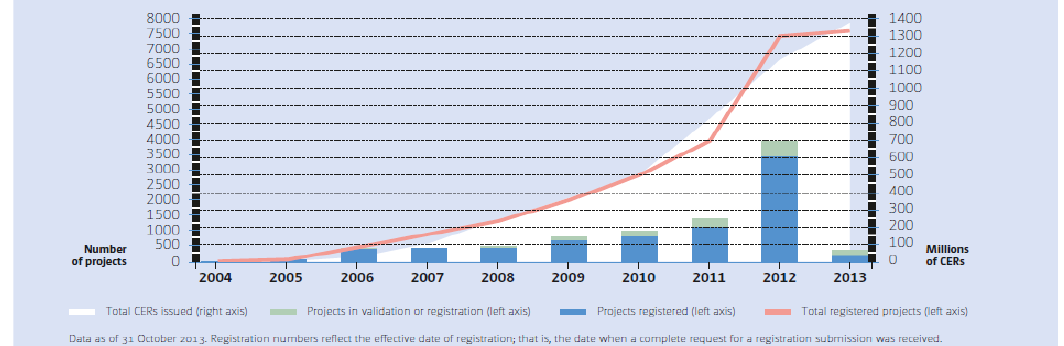
Fig. 1. Certified emission reductions issued cumulative, projects registered cumulative, and ptojects registered, registering and in validation by year, 2004  2013